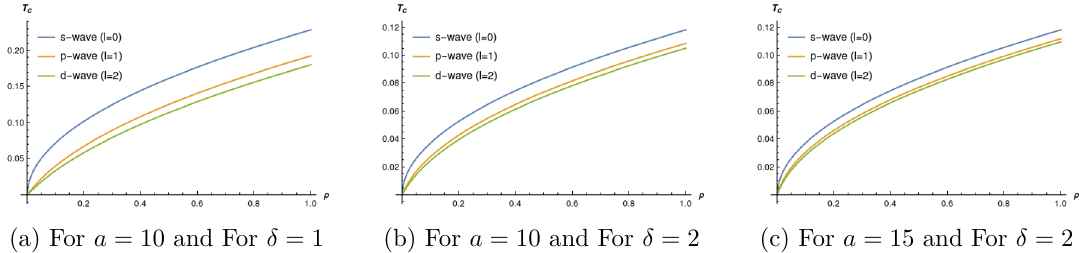
Figure 9. T c plot in term of charge density for different sample sizes a = (10 , 15) for l = 0( s -wave ) , l = 1( p -wave ) , l = 2( d -wave ) states with different δ of the scalar field